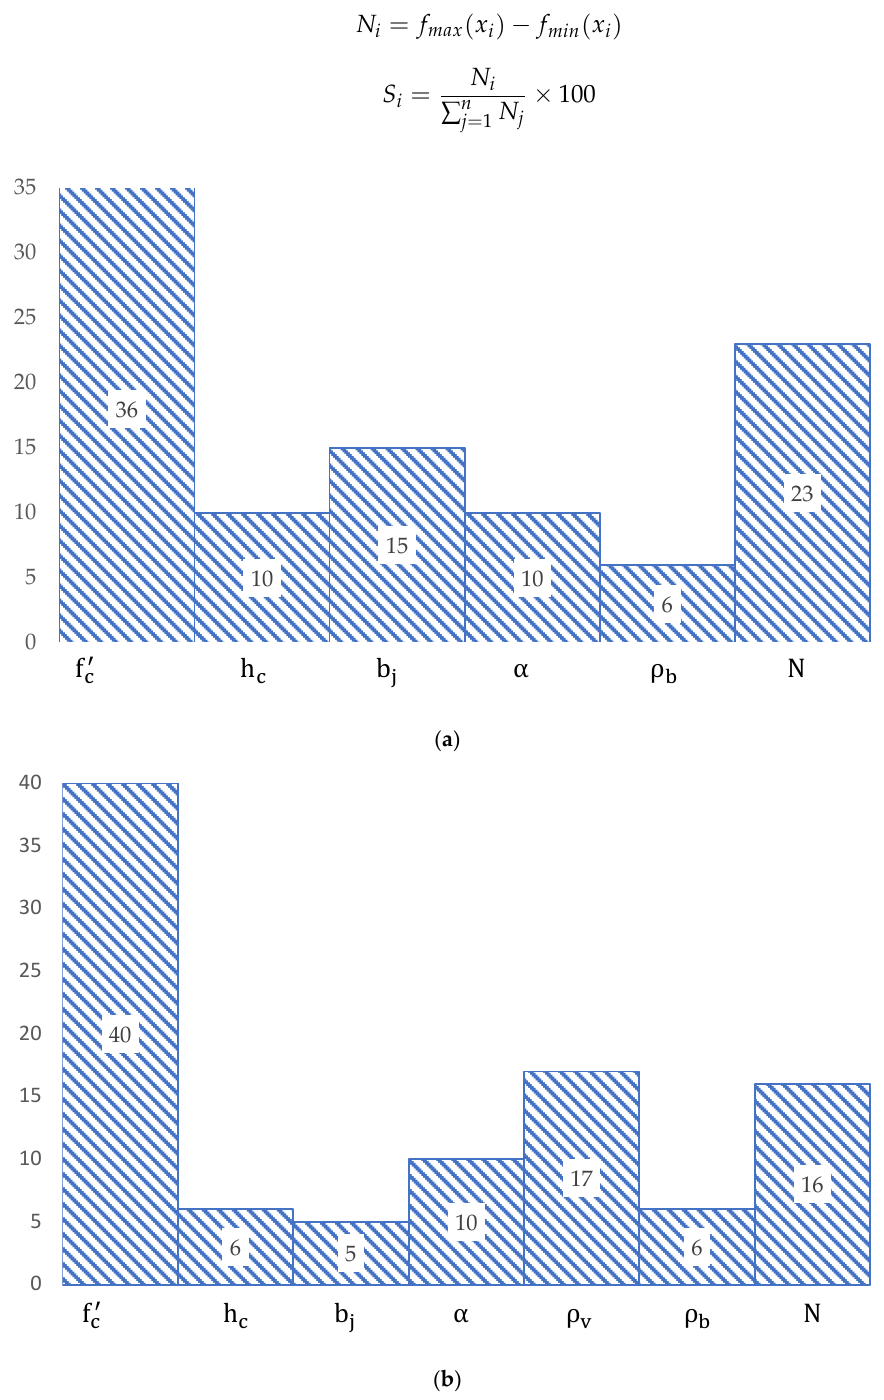
Figure 11. Relative contributions of key influencing variables; ( a ) unreinforced joint, ( b ) reinforced joint. The f max ( x i ) and f min ( x i ) denote the respective maximum and minimum of the predicted output over the i th